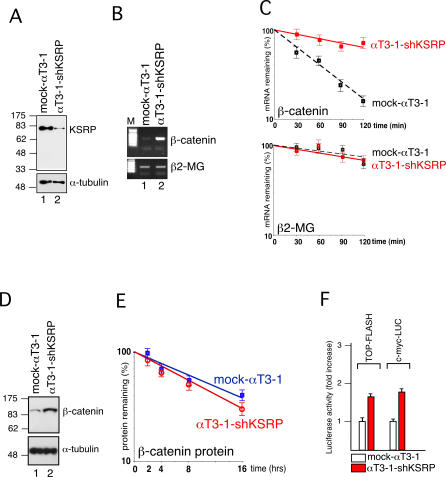
KSRP Is Required for β-Catenin mRNA Degradation(A) Immunoblot analysis of total extracts from either mock αT3-1 (empty pSUPER-Puro vector-transfected) or αT3-1-shKSRP (pSUPER-Puro-shKSRP–transfected) cells using affinity-purified anti-KSRP and anti–α-tubulin antibodies.(B) Expression of β-catenin and β2-MG, monitored by RT-PCR, in either mock αT3-1 or αT3-1–shKSRP cells.(C) Quantitative RT-PCR analysis of both β-catenin and β2-MG transcripts in either mock αT3-1 or αT3-1–shKSRP cells. Total RNA was isolated at the indicated times after the addition of actinomycin D. The values shown are averages (±SEM) of three independent experiments performed in duplicate.(D) Immunoblot analysis of total extracts from the indicated cell lines with anti–β-catenin and α-tubulin antibodies.(E) Either mock αT3-1 or αT3-1–shKSRP cells were treated with cycloheximide (50 μg/ml) for the indicated times. Total cell extracts were prepared and the levels of β-catenin quantitated by immunoblotting and densitometric scanning. Results are the average (±SEM) of three experiments. α-Tubulin immunoblotting was used to verify the equal protein loading.(F) Either mock αT3-1 or αT3-1–shKSRP cells were transiently transfected with either TOP-FLASH or c-myc-LUC reporter vectors, cultured for 2 d, and collected, and luciferase activity was measured. The values shown are averages (±SEM) of four independent experiments performed in duplicate.